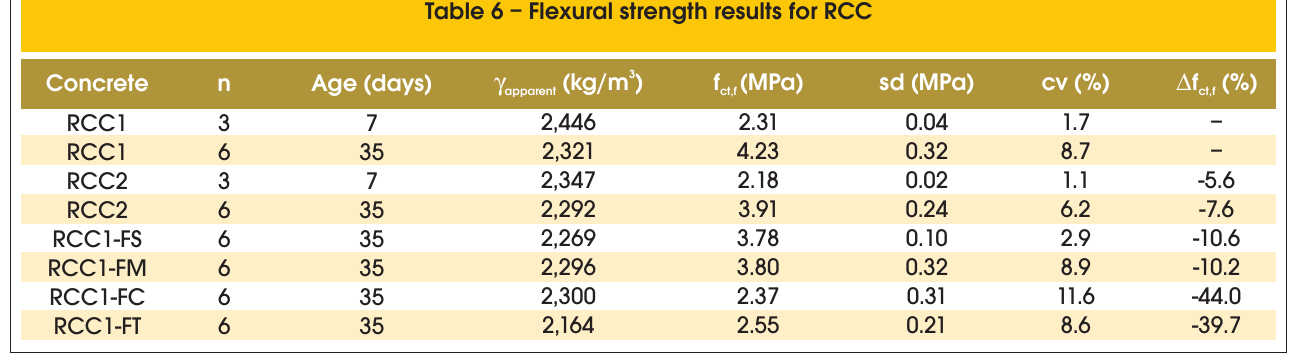
Table 6 – Flexural strength results for RCC